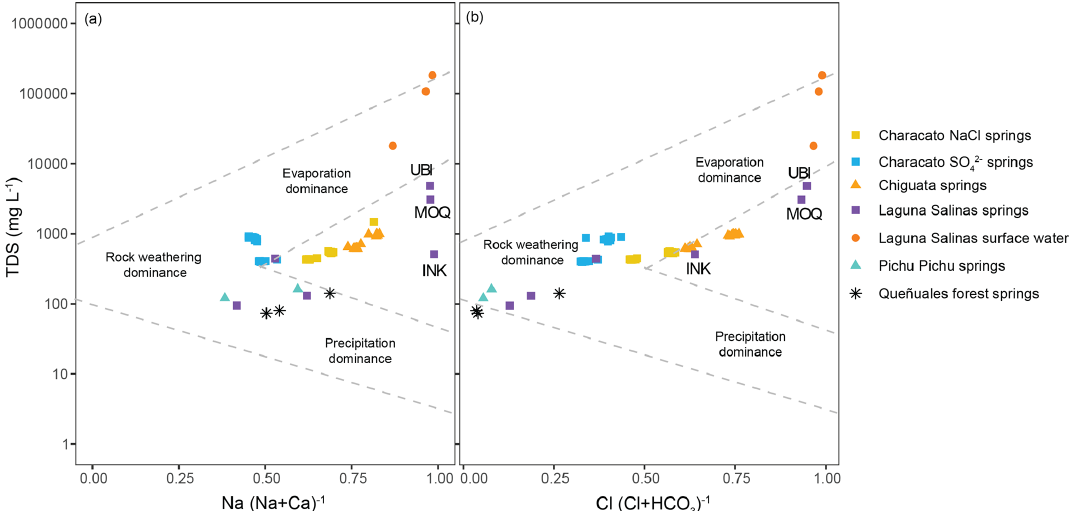
Figure 6. Gibbs (a) cation and (b) anion diagram for the ratios of major ion compositions calculated using units of parts per million (ppm). Springs in our study area show a distribution of evaporation, rock weathering, and precipitation influence on the groundwater chemistry. Select springs discussed in the text are labelled with their sample ID.